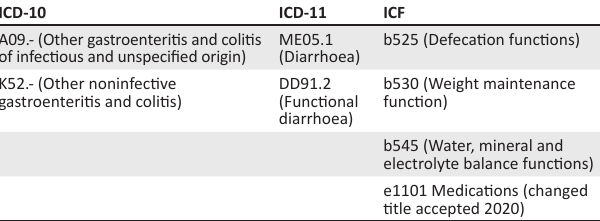
TABLE 2: Service coverage indicator using the International Classification of Functioning, Disability and Health. Coverage of diarrhoea treatment.